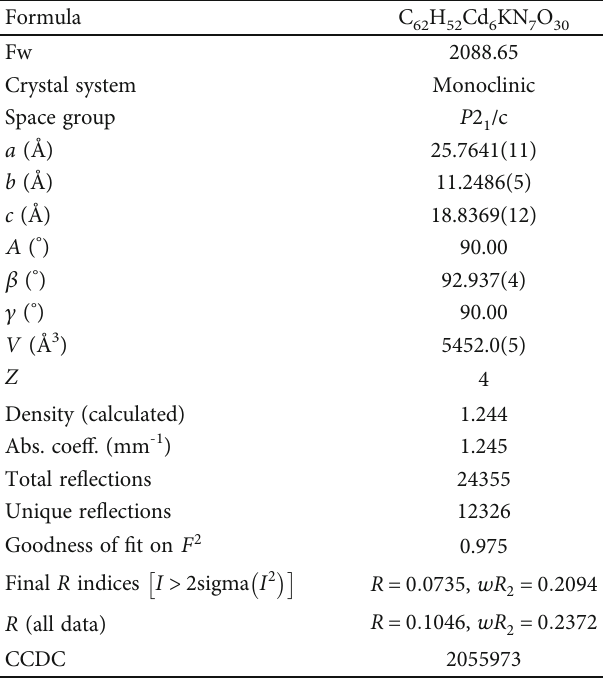
Table 1: Crystal data and structure re fi nements for compound 1 .